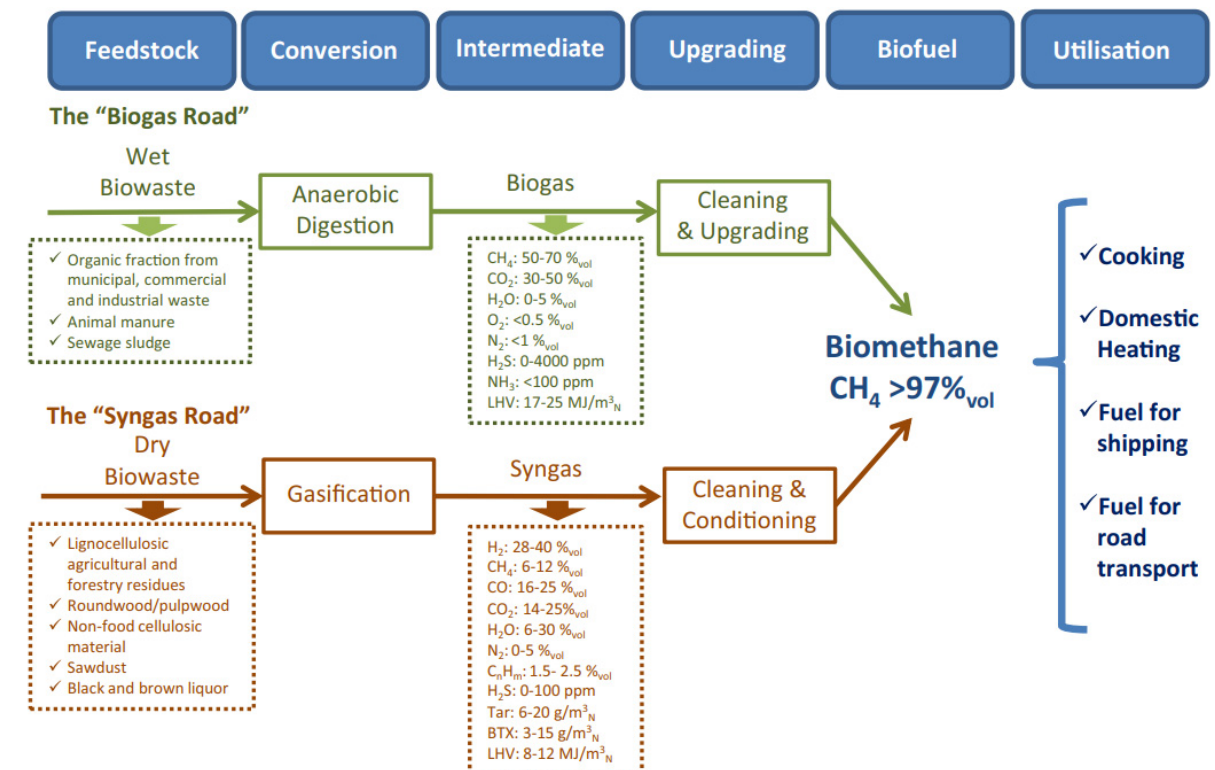
Figure 14. Biogas and syngas roads for biomethane production [110].